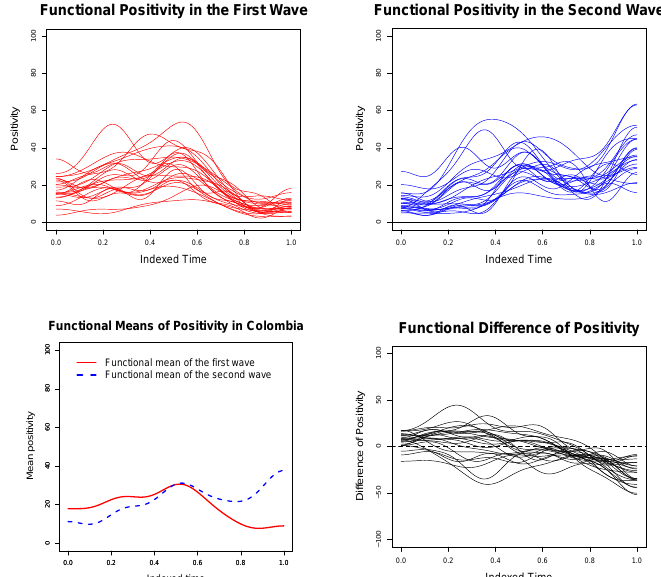
Figure 4. Functional positivity data for COVID-19 in Colombia for Case 1: Functional positivity in the first wave ( top left ); functional positivity in the second wave ( top right ); functional means of positivity in the first wave in solid line and the second wave in dashed line ( bottom left ); positivity difference curves ( bottom right ).